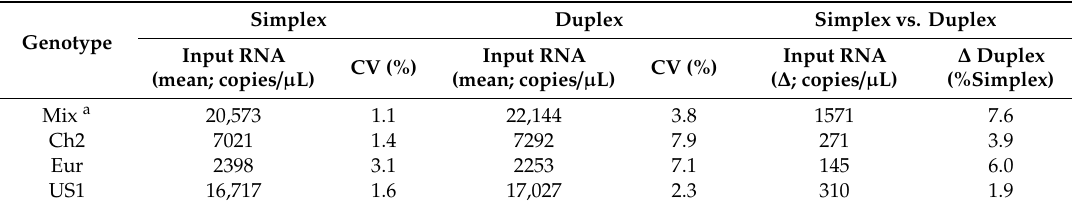
Table 1. Comparison of pepino mosaic virus (PepMV) RNA quantification using simplex and duplex reverse-transcription digital polymerase chain reaction (RT-dPCR) assays performed on Naica.